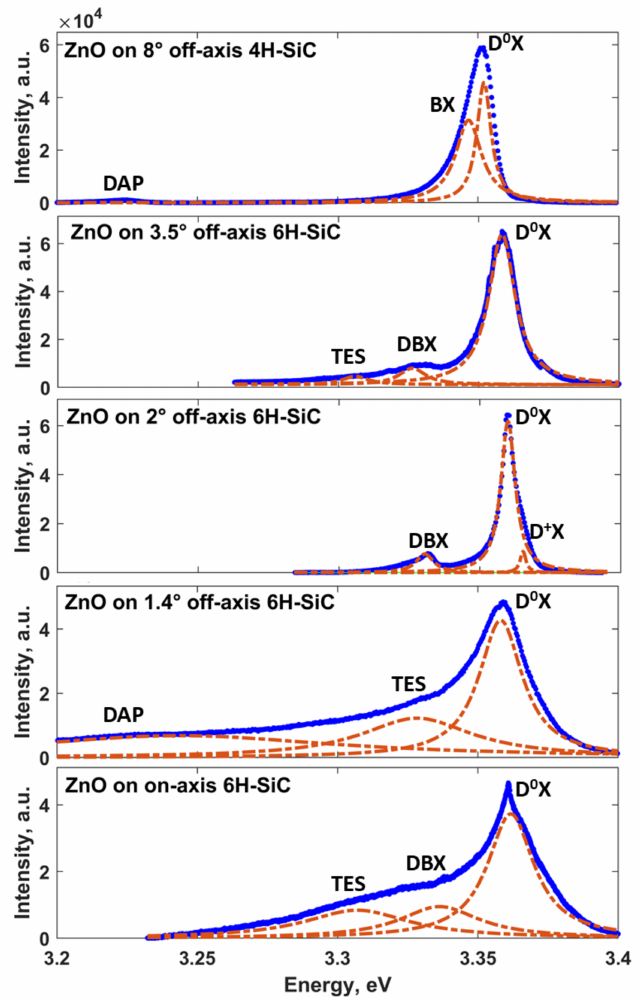
Figure 4. Low-temperature PL spectra (at 4 K) with peak assignment for ZnO films grown on SiC substrates with different off-cut angles: the off-axis angle increases from the bottom panel to the top panel. Blue solid lines are experimental data, while the dash-dot orange curves are the fitting Lorentzian curves. At this temperature, the large fraction of electrons is localized at donor centers related to dopants or defects, and thus, PL spectra are dominated by emissions from bound excitons. Therefore, no FX emission is observed in the low-temperature regime. Fitting errors are estimated to be 2.648%, 2.846%, 1.591%, 1.29%, and 1.632% for ZnO films grown on SiC substrates with different off-cut angles: 0 ◦ , 1.4 ◦ , 2 ◦ , 3.5 ◦ , and 8 ◦ ,